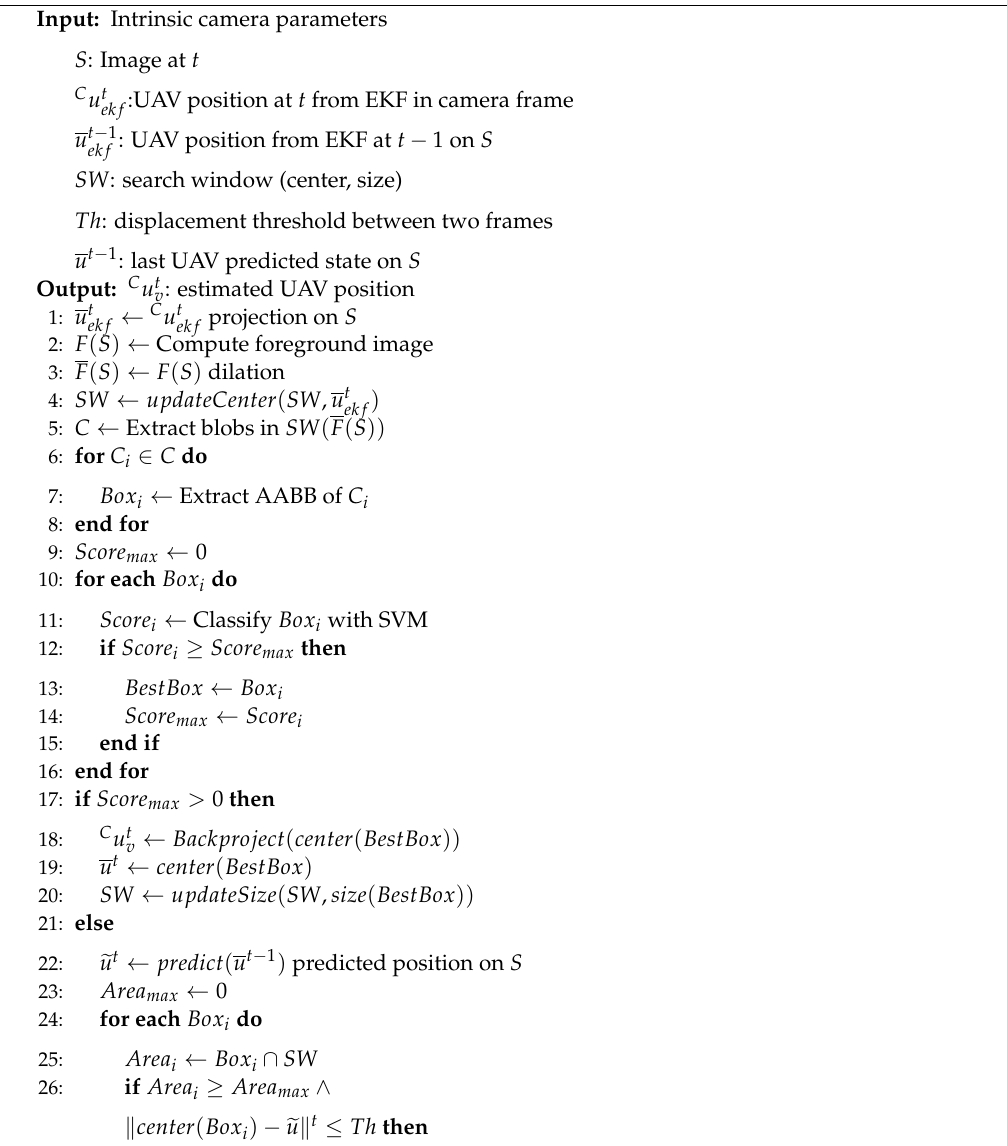
Algorithm 1: Vision-based UAV